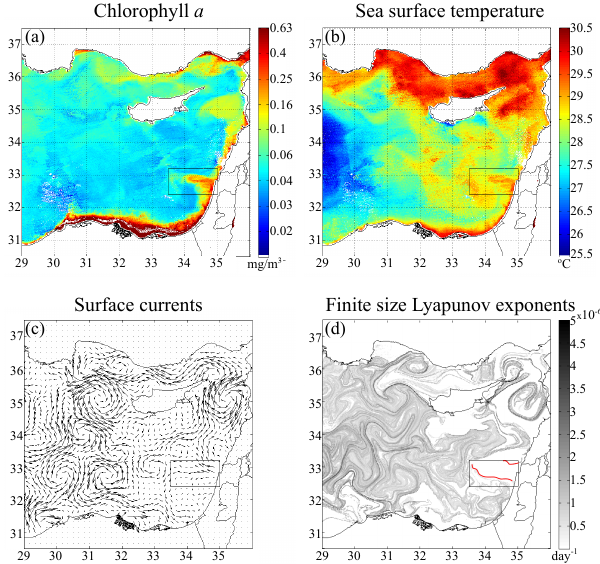
Fig. 2. Satellite-derived maps of the Levantine Basin of the East- ern Mediterranean (a) chlorophyll a concentrations, (b) sea surface temperature, (c) surface currents and (d) finite size Lyapunov ex- ponents, from 22 August 2011. The boxes mark the area shown in Fig. 3. The red lines in panel d highlight the unstable manifolds constraining the patch from the north and from the south (see